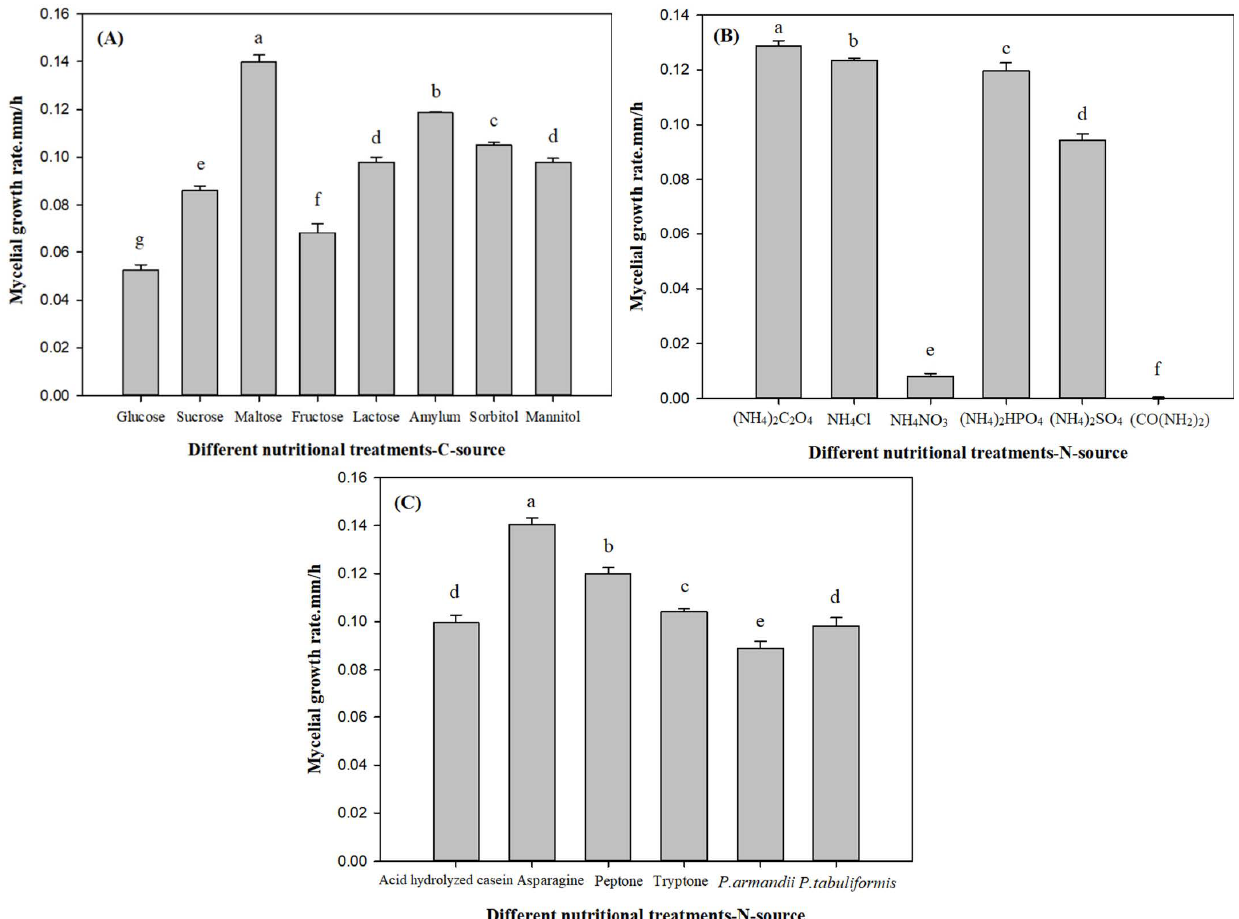
Figure 3. Effects of different nutritional treatments on mycelial growth rate. Mycelial growth rate is expressed as the mean ± S.E (mm/h), and the different letters above the bars indicate significant differences ( p < 0.01, Tukey’s HSD test). Eight biological replicates in carbon sources ( A ), 6 biological replicates in inorganic nitrogen sources ( B ), 4 biological replicates in organic nitrogen sources and 2 host nutrition biological replicates ( C ); 5 technical replicates for each biological treatment.